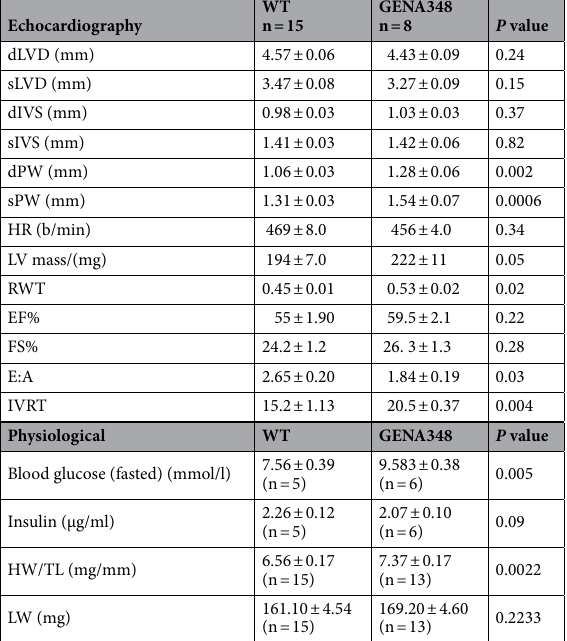
Table 1. Summary of echocardiography and physiological parameters in GENA348 mice compared to WT (6 months of age). dLVD diastolic diameter, sLVD systolic diameter, dIVS diastolic intraventricular septum, sIVS systolic intraventricular septum, dPW diastolic posterior wall, sPW systolic posterior wall, HR heart rate, EF ejection fraction, FS fractional shortening, LV mass left ventricular mass, RWT relative wall thickness, E:A early to late ventricular filling ratio, IVRT isovolumetric relaxation time, HW heart weight, TL tibia length, LW lung weight. Data are presented as the mean ± SEM ( P < 0.05 considered as a significant